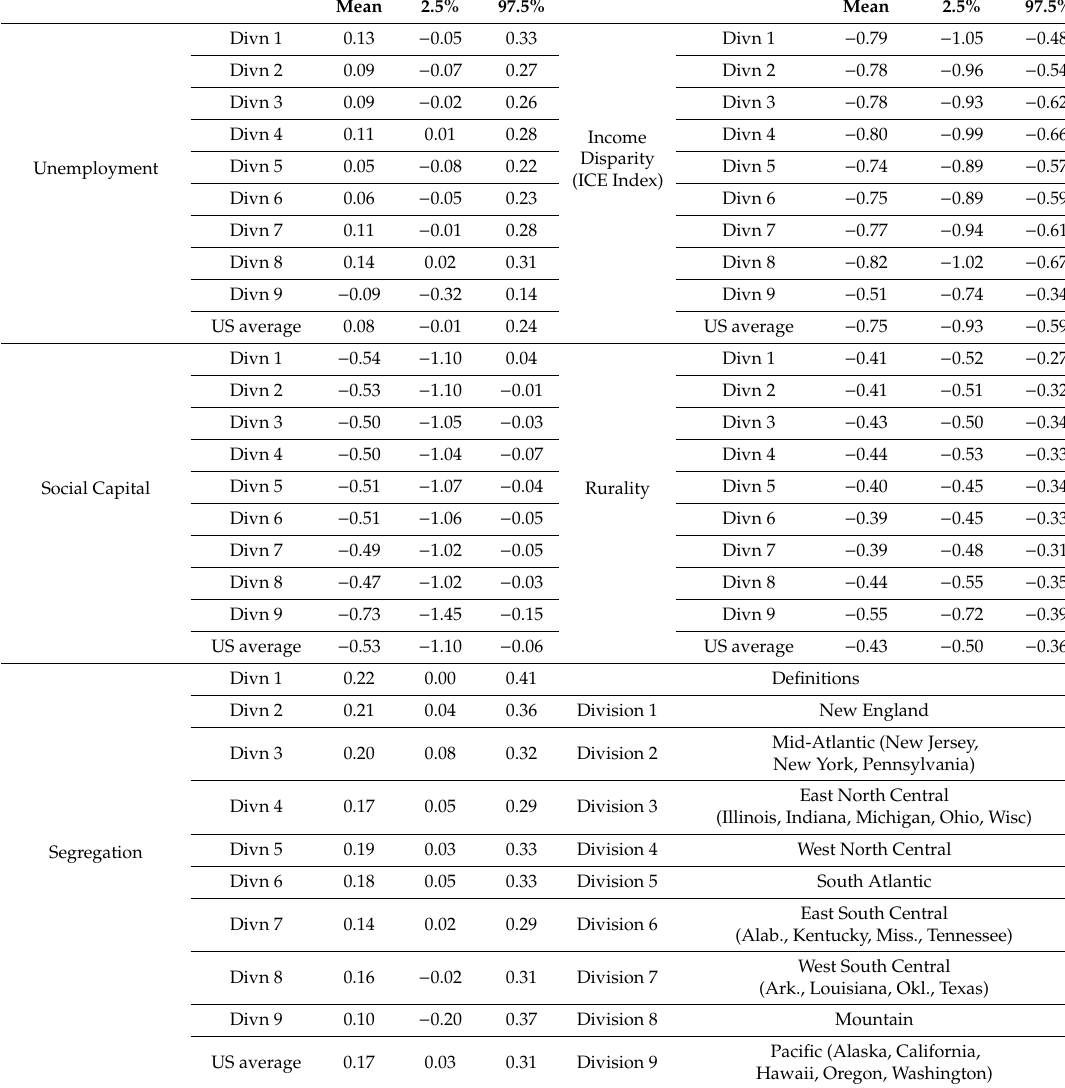
Table 3. Varying Predictor E ff ects according to US Census Divisions (Posterior Mean E ff ects and 95%